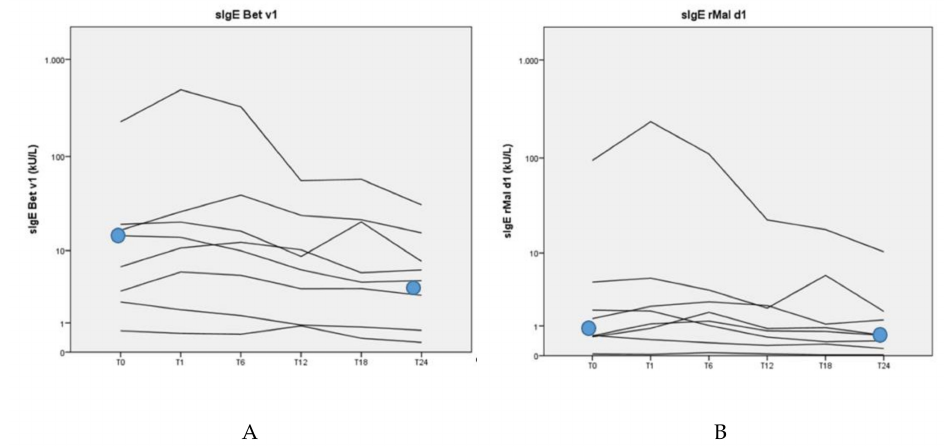
Figure 2. sIgE in response to Bet v 1 ( A ) and rMal d 1 ( B ) over time (in months) during BP-AIT in logarithmic